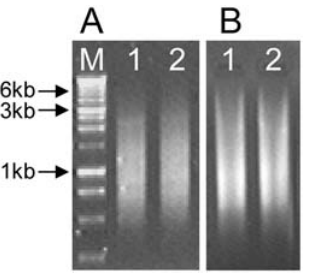
Figure 1. Agarose gel electrophoresis of SL-based full-length cDNA libraries of dinoflagellates. A) Amphidinium carterae (CCMP1314). B) Karlodinium veneficum (CCMP1975). First strand cDNA libraries were synthesized from 1 m g (lane 1) or 2.5 m g (lane 2) total